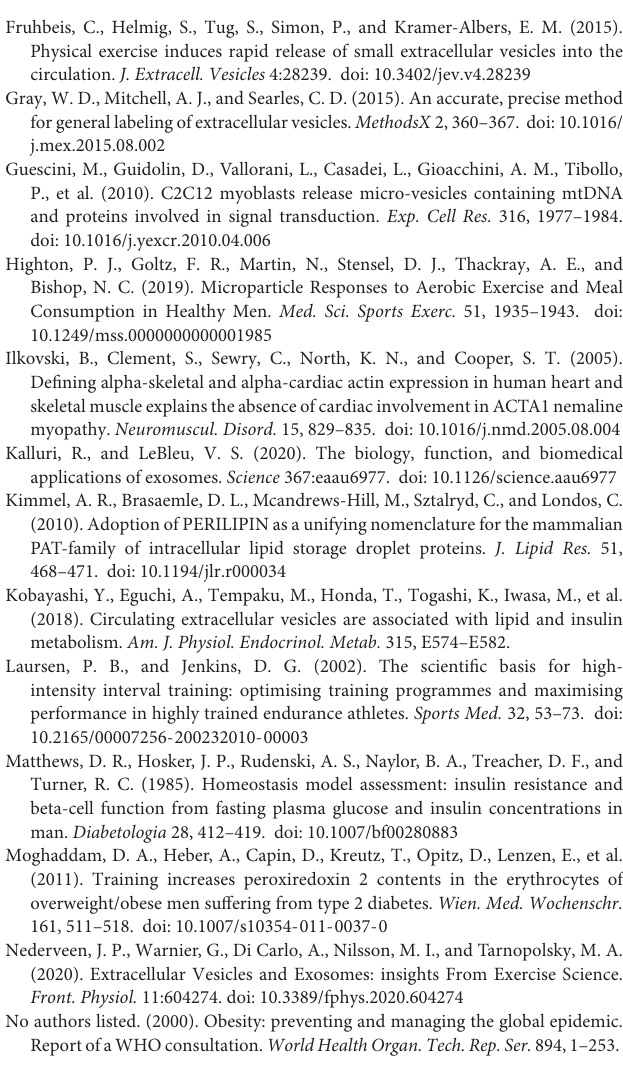
Supplementary Figure 1 | The whole membrane of Western blotting for Figure 3B . Supplementary Figure 2 | The whole membrane of Western blotting for Figure 5E . Supplementary Table 1 | Biochemical parameters before and after HIIT-Ex. Supplementary Table 2 | The list of